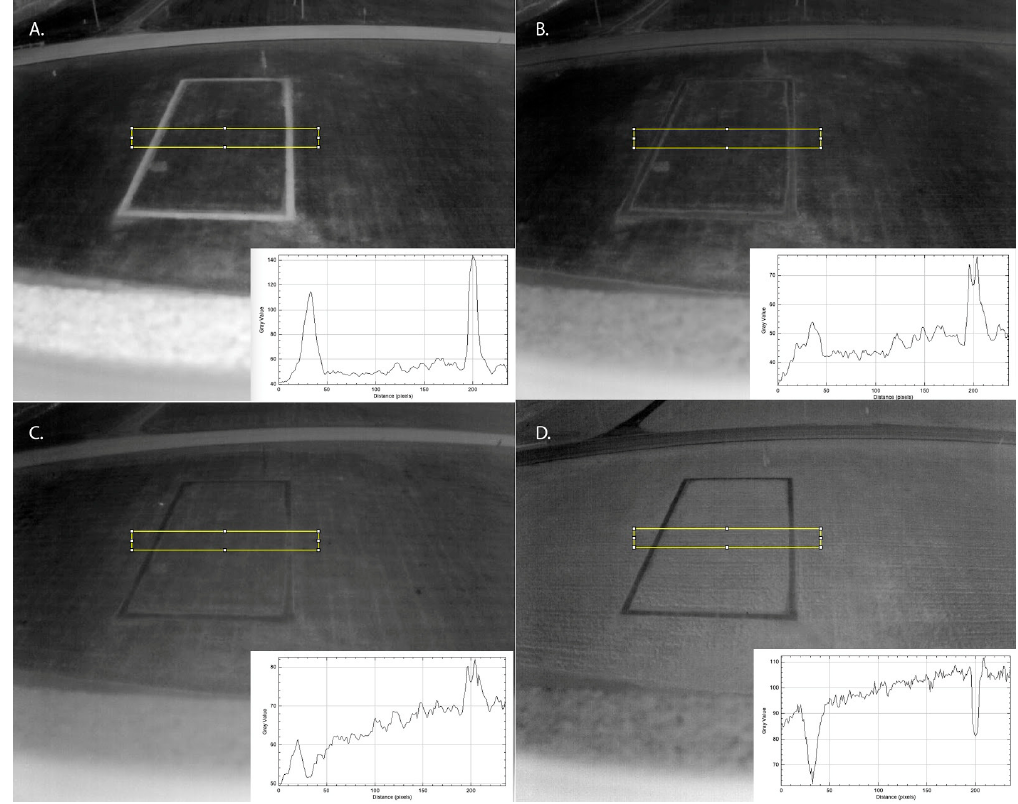
Figure 9. Individual images from a time lapse recording of one part of the main lawn at the Enfield Shaker Village recorded on 16 October 2018. Inset graph shows the average pixel value across the highlighted region (yellow): ( A ). Just after sunset (around 6 p.m.) ( B ). A few hours after sunset (around 10 p.m.) ( C ). After dew appears (approximately 2 a.m.) ( D ). Just after dawn (approximately 7:30 a.m.).